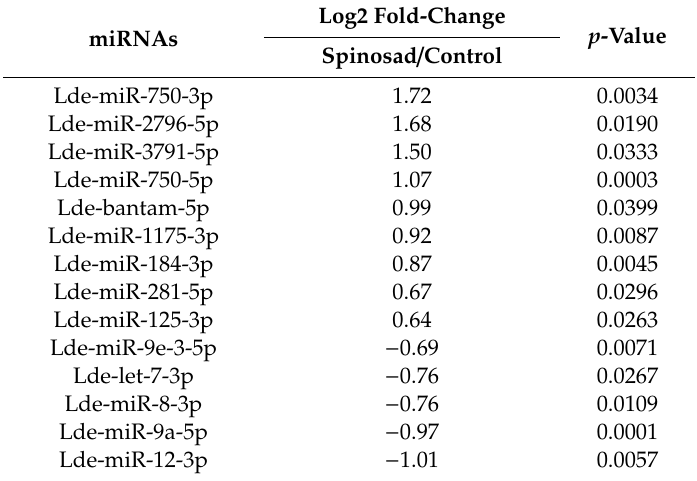
Table 5. Spinosad-modulated miRNAs in L. decemlineata as determined by NGS. Presented miRNA transcripts displayed absolute log2 fold-changes above 0.5 and p values below 0.05. Log2